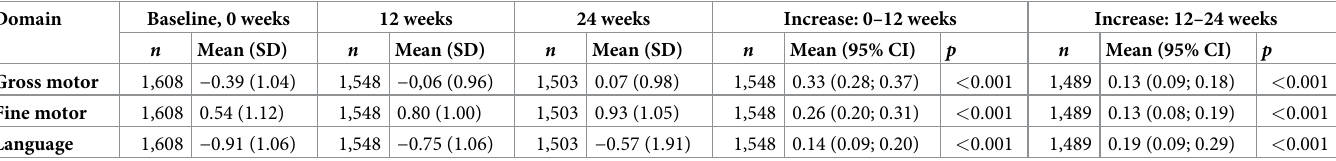
Table 2. Changes in MDAT z-scores at end of intervention (12 weeks) and after intervention (24